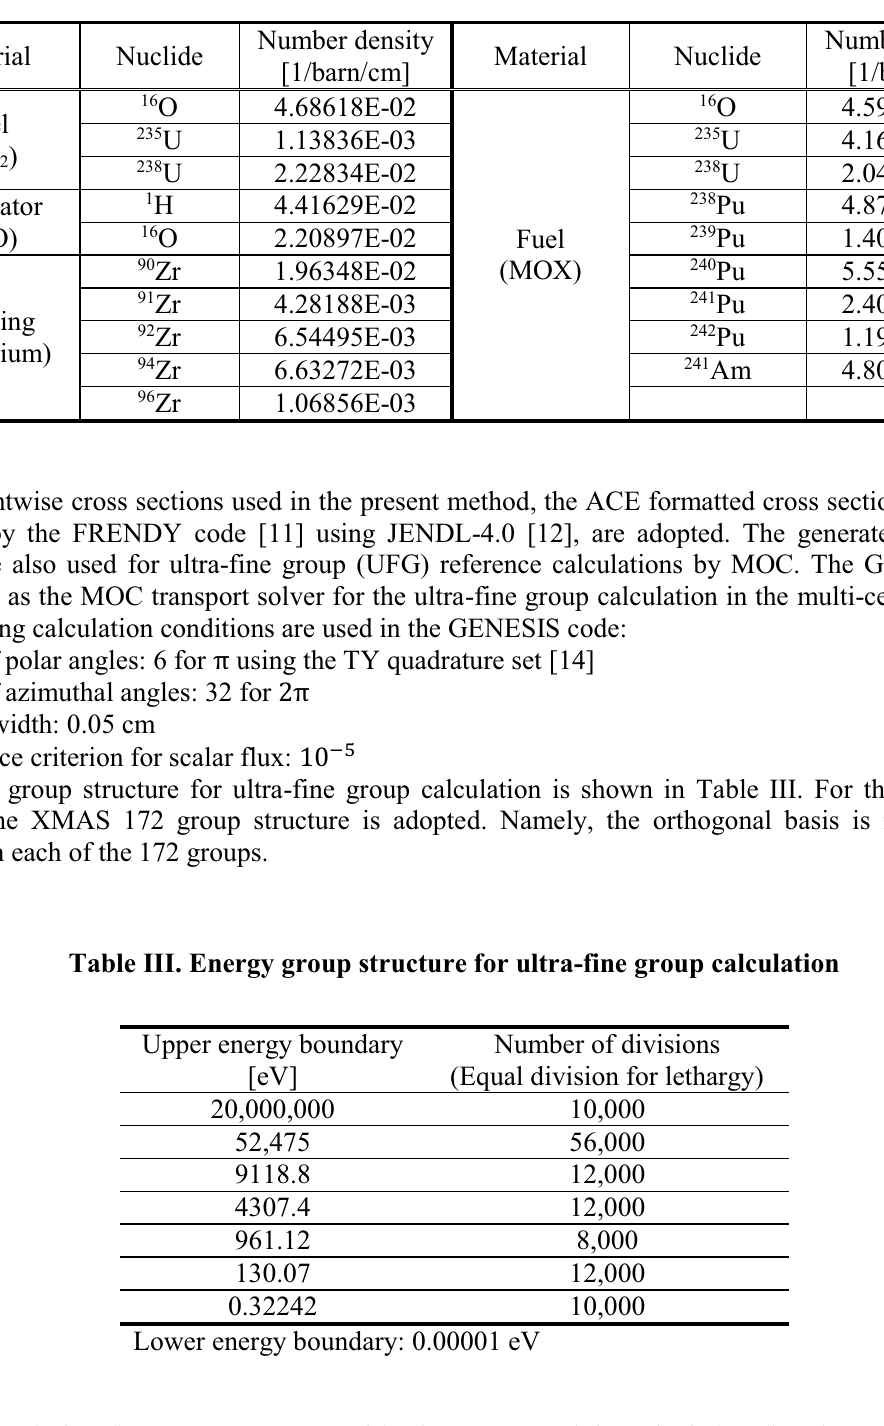
Table II. Compositions of materials